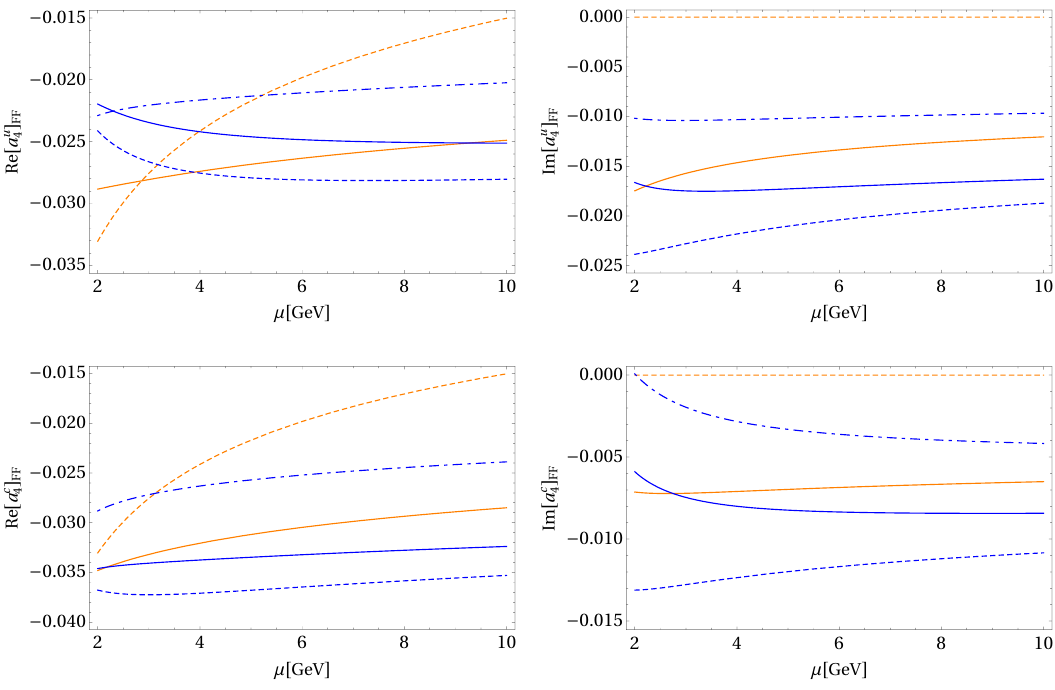
Figure 9 . Scale dependence of a u ( (cid:25) (cid:22) K ) (upper row) and a c ( (cid:25) (cid:22) K ) (lower row). The spectator- 4 4 scattering contribution is not included here. Real part to the left, imaginary part to the right. Line coding: full NNLO (solid, dark-grey/blue), NNLO j Q (dash-dotted, dark- 3 (cid:0) 6 ; 8 g grey/blue), NNLO j Q (dashed, dark-grey/blue), NLO (solid, light-grey/orange), LO (dashed, 1 ; 2